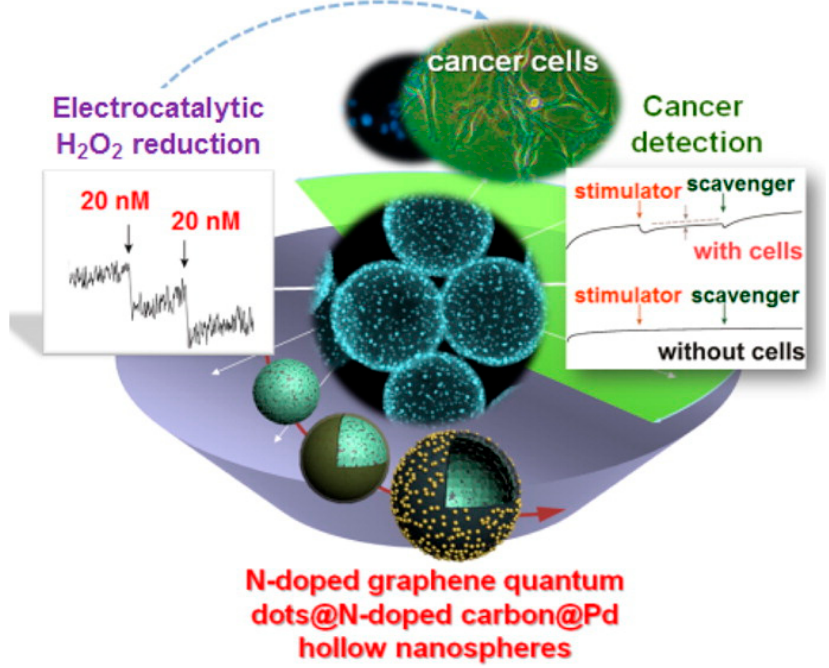
Scheme 10. Electrochemical sensing performance in cancer detection. Reproduced with permission from ref. [102]. Copyright 2016, American Chemical Society.